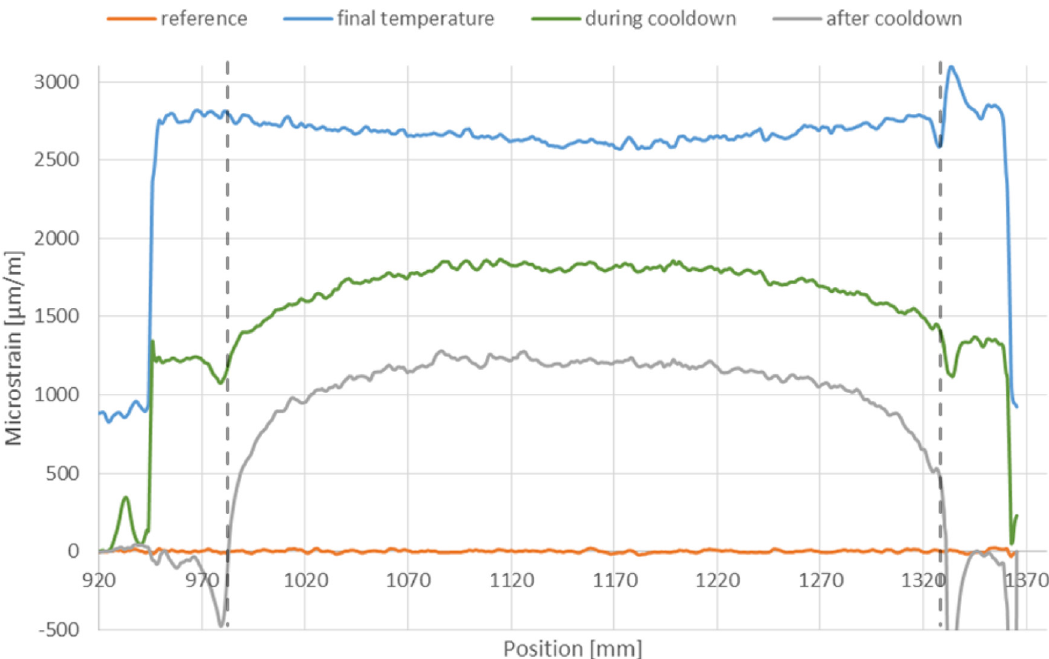
Fig. 8. Deformation during the